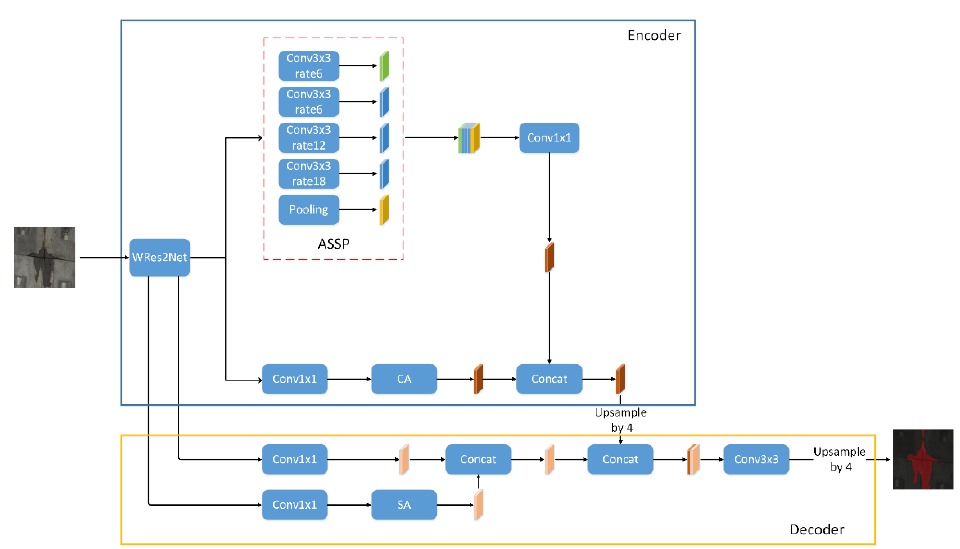
Figure 6. WRDeeplabv3+ overall model.